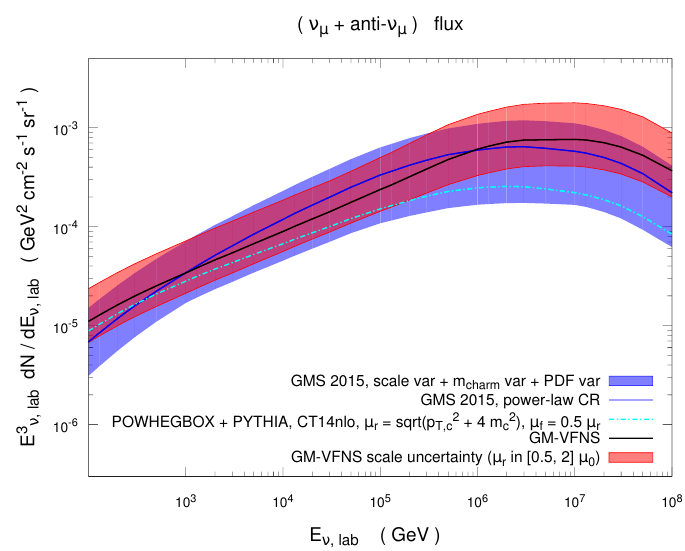
Figure 12 . Prompt-( (cid:23) (cid:22) + (cid:22) (cid:23) (cid:22) ) (cid:13)uxes as functions of neutrino energy E (cid:23); lab . Predictions in the GM-VFNS according to the computation presented in this paper (red band) are compared with predictions by POWHEGBOX + PYTHIA (blue band), with hard scattering in the FFNS, according to the computation in ref. [5]. In particular, the blue line and band refer to central values and QCD uncertainties of the predictions obtained in ref. [15] (GMS 2015) using central scales (cid:22) r = (cid:22) f = (cid:22) 0 = p 2 + 4 m 2 , with variations ( (cid:22) r ; (cid:22) f ) = [(0 : 5 ; 0 : 5) ; (2 ; 2) ; (0 : 5 ; 1) ; (1 ; 0 : 5) ; (1 ; 2) ; (2 ; 1)]( (cid:22) 0 ; (cid:22) 0 ), c T;c the 28 uncertainty sets of ABM11nlo -3(cid:13) PDF, and m c = (1.4 q dashed line refers to predictions by POWHEGBOX + PYTHIA using (cid:22) r = m c = 1.3 GeV and the central set of the CT14nlo-3fl PDFs. The broken-power-law CR primary spectrum is used as input in all